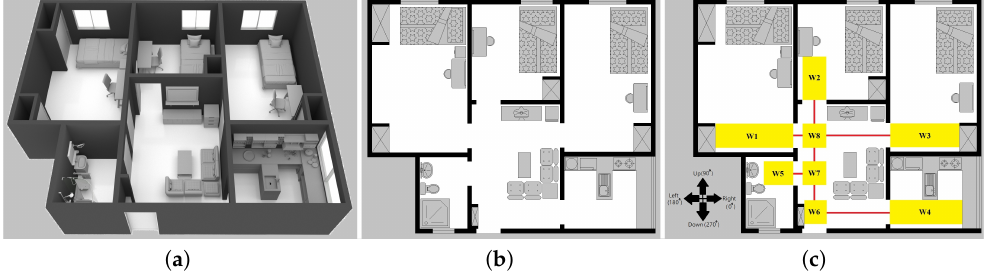
Figure 2. The apartment that is chosen for this study. ( a ) Perspective view, ( b ) 2D Floor Plan, ( c ) Topological map.